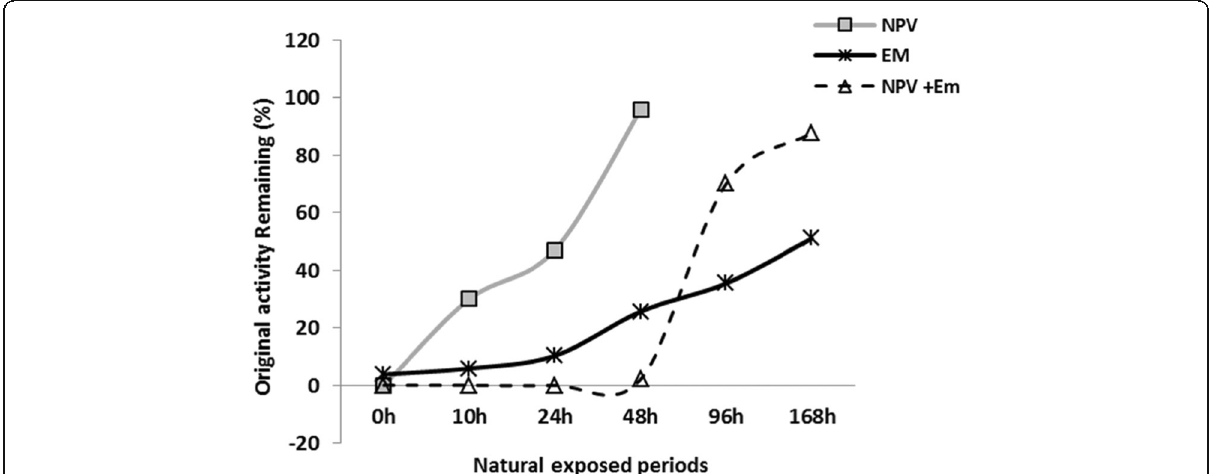
Fig. 5 Percentage reduction in the spli NPV activity expressed in original activity remaining (OAR) of Spodoptera littoralis 2nd instar larvae treated with Spli MNPV, Em, and Em LC 50 + Spli MNPV Lc 99 all exposed to different natural sunlight